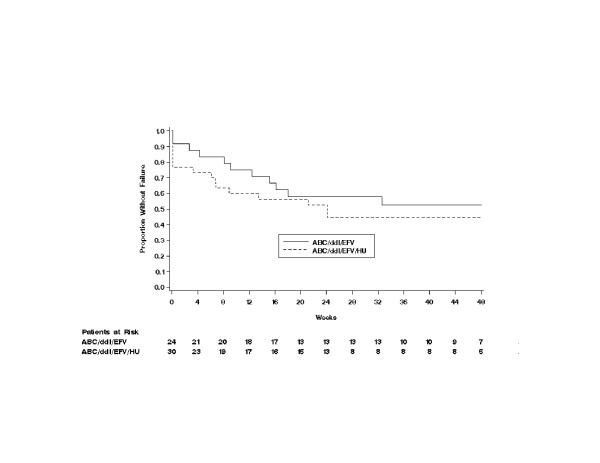
Time to treatment failure. ABC = abacavir; ddI = didanosine; EFV = efavirenz; HU = hydroxyurea. Virologic failure was defined by any of the following: HIV-1 RNA >400 copies/mL by week 24, repeated detection (>400 copies/mL) after initial suppression to undetectable levels (<400 copies/mL) or a 3-fold or greater increase in plasma HIV-1 RNA level from the nadir at week 8 or later.